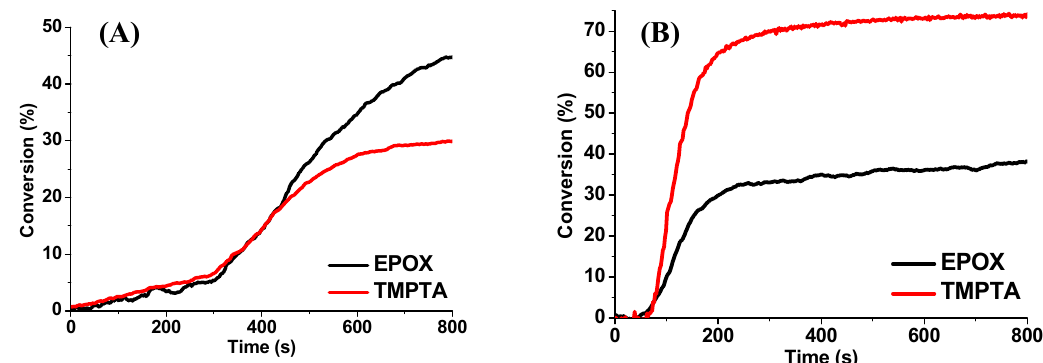
Figure 6. Polymerization profiles of an EPOX / TMPTA blend (50% / 50%, w / w ) using the three-component Cu-2 / Iod / NVK (0.1% / 3% / 5%, w / w / w ) system under air ( A ) and in laminate ( B ), irradiation with a